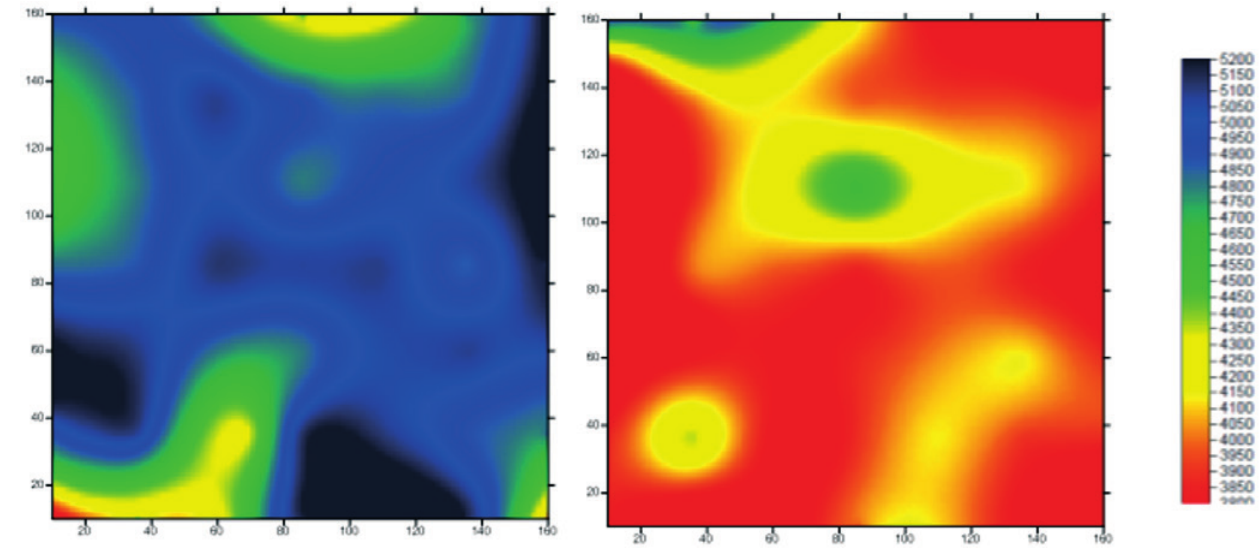
(a) images generated from the wall with smooth surface (b) images generated from the wall with rough